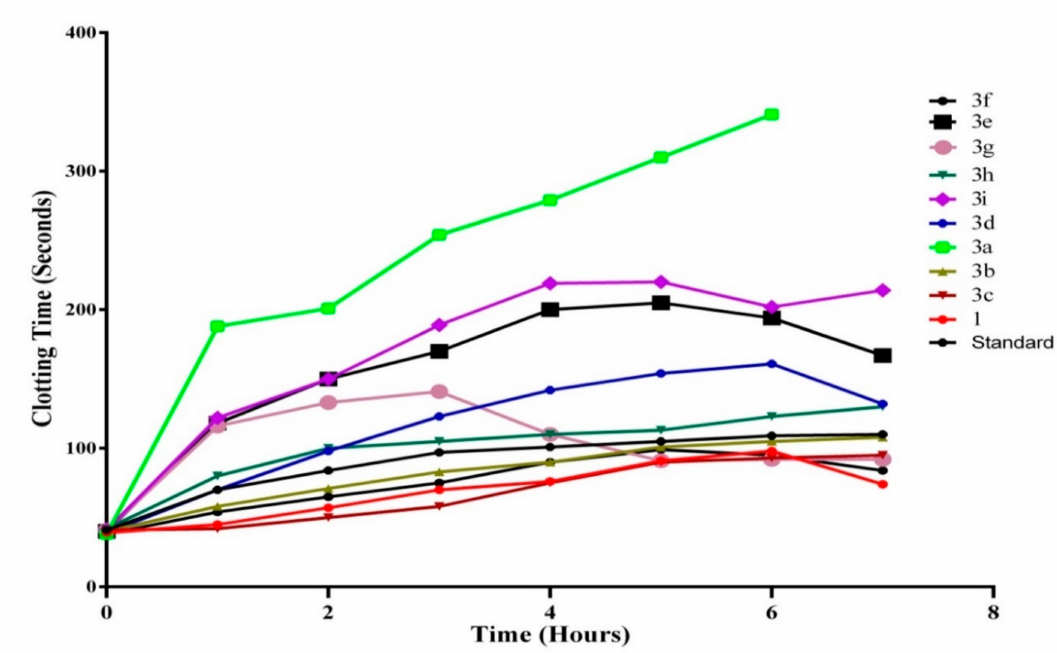
Figure 1. Time course determination of anticoagulation activity of tested compounds 3a – 3i and 1 . Heparin was used as standard